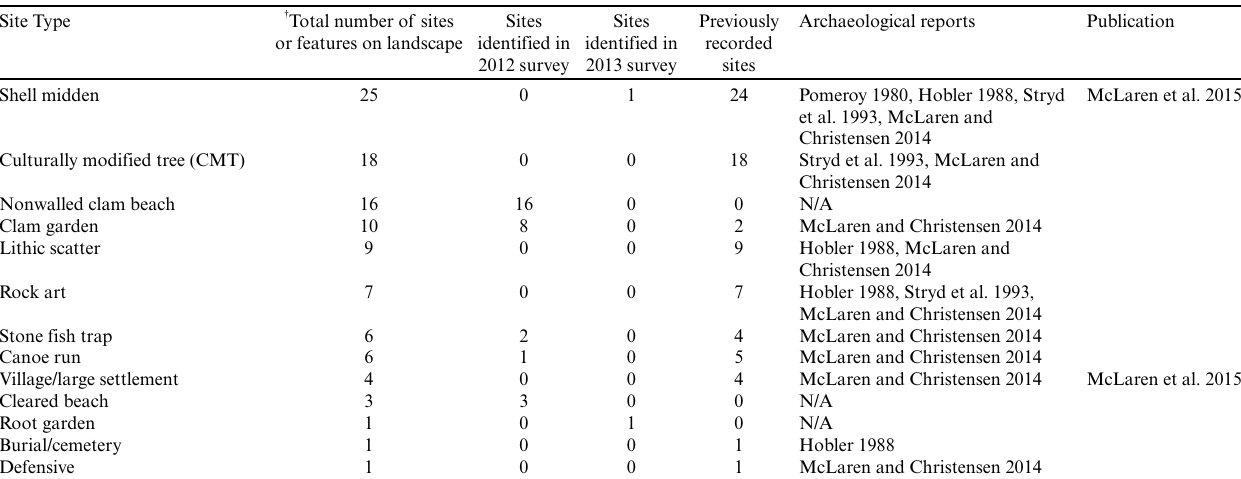
Table 1 . Our shoreline surveys at low tide, in combination with previous records, revealed a diverse range of archaeological site types within Kwakshua Channel, British Columbia, Canada.